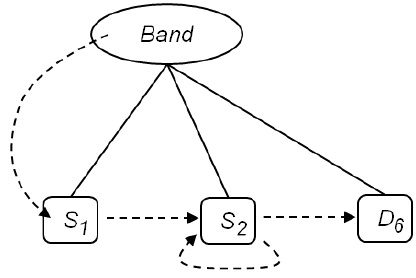
Figure 19. The simplified object life model of a band. Source: